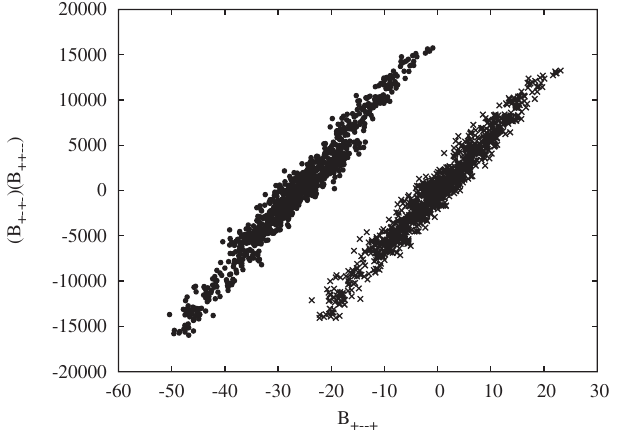
FIG. 10. B þ(cid:3)þ(cid:3) B þþ(cid:3)(cid:3) vs B þ(cid:3)þ(cid:3) for a turn-by-turn measure- ment at BPM 66. There are 1000 turns of position measurements. The filled circles are derived from the measured button inten- sities. The x points are based on button values corrected with the fitted gains. The fitted gains are g ð 1:4 Þ ¼ 1 : 001 ; 0 : 982 ; 0